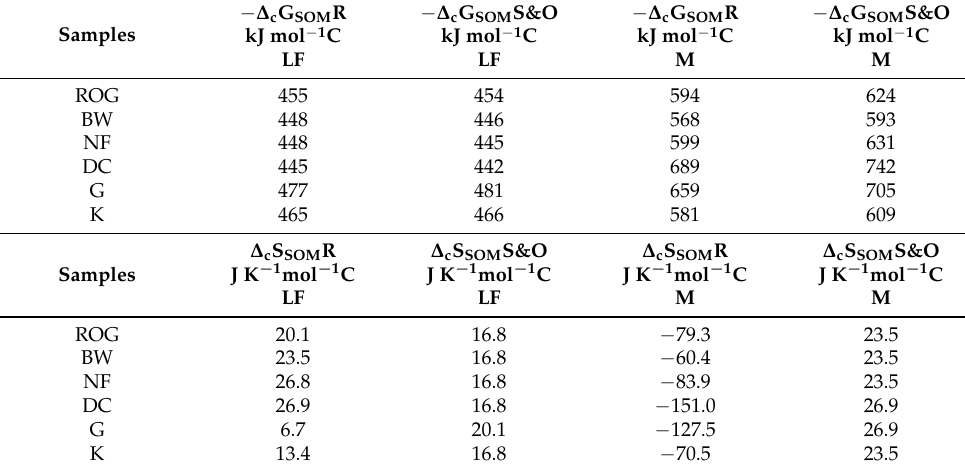
Table 3. Values of the Gibbs energy change of reaction (Equation (1)) obtained by applying the Roels correlation, − ∆ c G SOM R, and Sandler and Orbey correlation, − ∆ c G SOM S&O, for LF and mineral, M, samples, together with their respective entropy changes for Reaction (1). The residual standard error for calculation of − ∆ c G SOM R data is that reported by Roels, 18 kJ mol − 1 , and that for estimation of − 1 [26,27]. Samples ROG, BW, and NF are from the southeast of the UK. − ∆ c G SOM S&O is 21.5 kJmol Samples DC, G, and K are from the southwest of